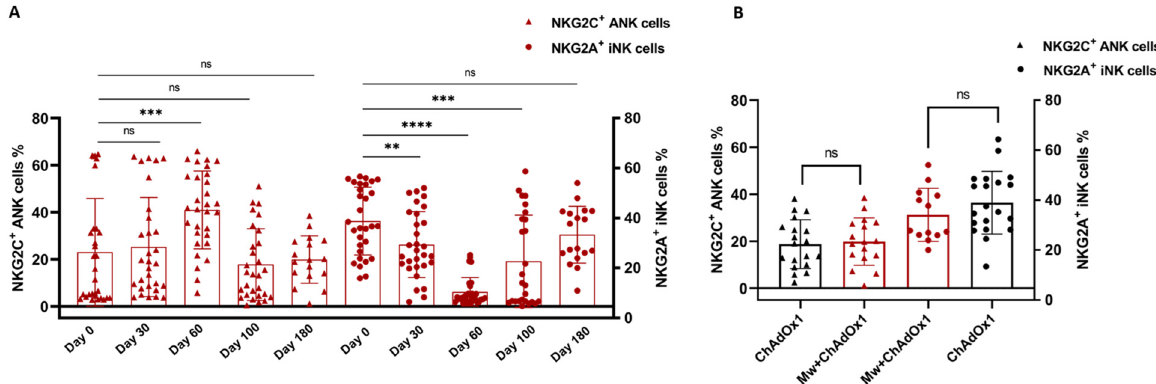
Figure 2 . Adaptive NK (ANK) cells and inhibitory NK (iNK) cells: Scatter dot with bar plot showing ( A ) the kinetics of NKG2C + ANK and NKG2A + iNK cells in Mw + ChAdOx1 group at baseline, day 30, day 60, day 100 and day 180. ( B ) Expression of NKG2C + ANK and NKG2A + iNK cells between Mw + ChAdOx1 and ChAdOx1 group at the time of enrolment. Red shaded triangles and dots represent NKG2C + ANK and NKG2A + iNK, respectively, for Mw + ChAdOx1 group. Black shaded triangles and dots represent NKG2C + ANK and NKG2A + iNK, respectively, for ChAdOx1 group. ** p < 0.01, *** p < 0.001, **** p < 0.0001 and ns = p -value not significant.